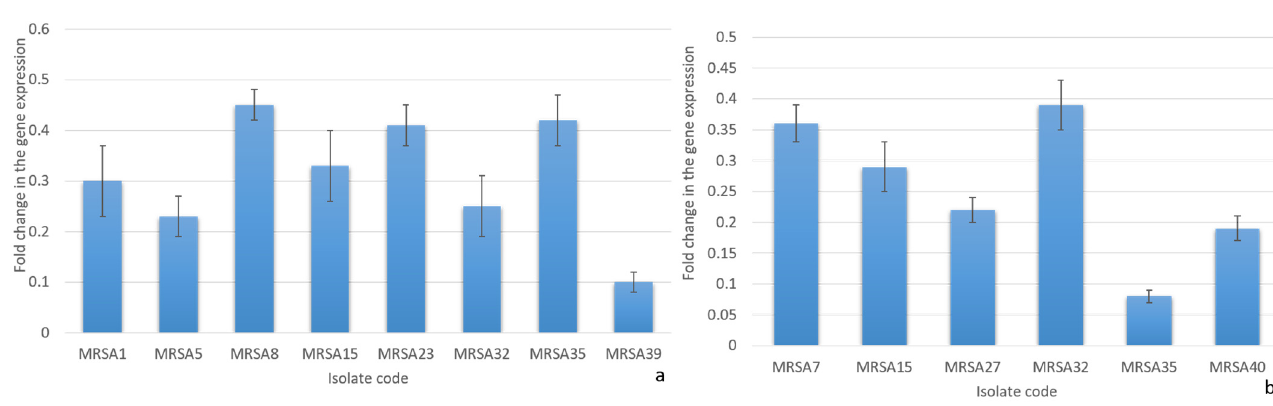
Figure 3. The charts show the fold changes in the transcriptional levels of ( a ) nor A and ( b ) nor B genes after treatment with the diethyl ether extract of C. macrocarpa leaves.